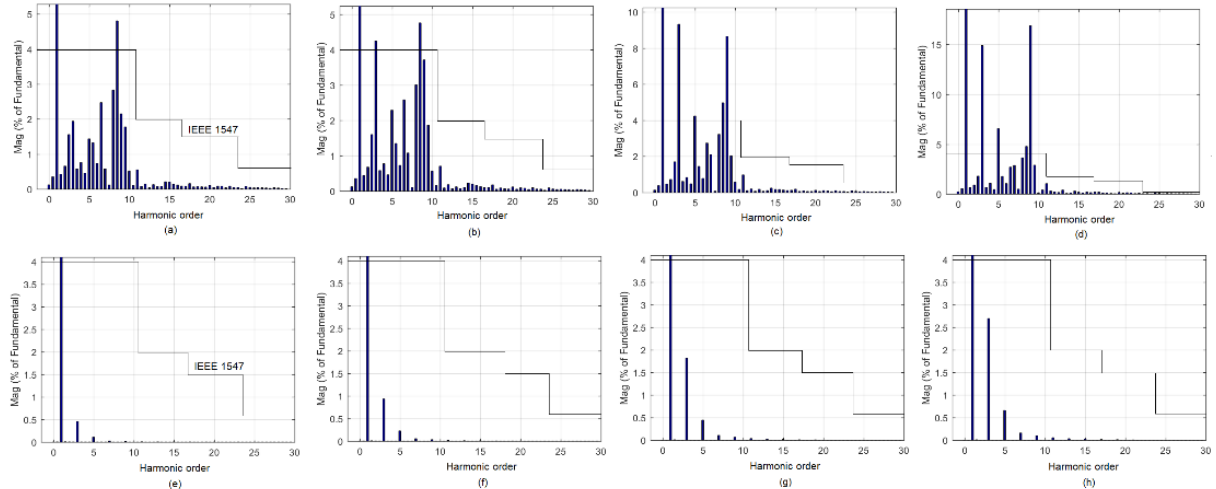
Figure 5. Harmonic spectra and the limits of IEEE 1547 Standard for the grid currents without and with control under 25%, 50%, 100%, and 150% rated loads, ( a – d ) without control, and ( e – h ) with control.